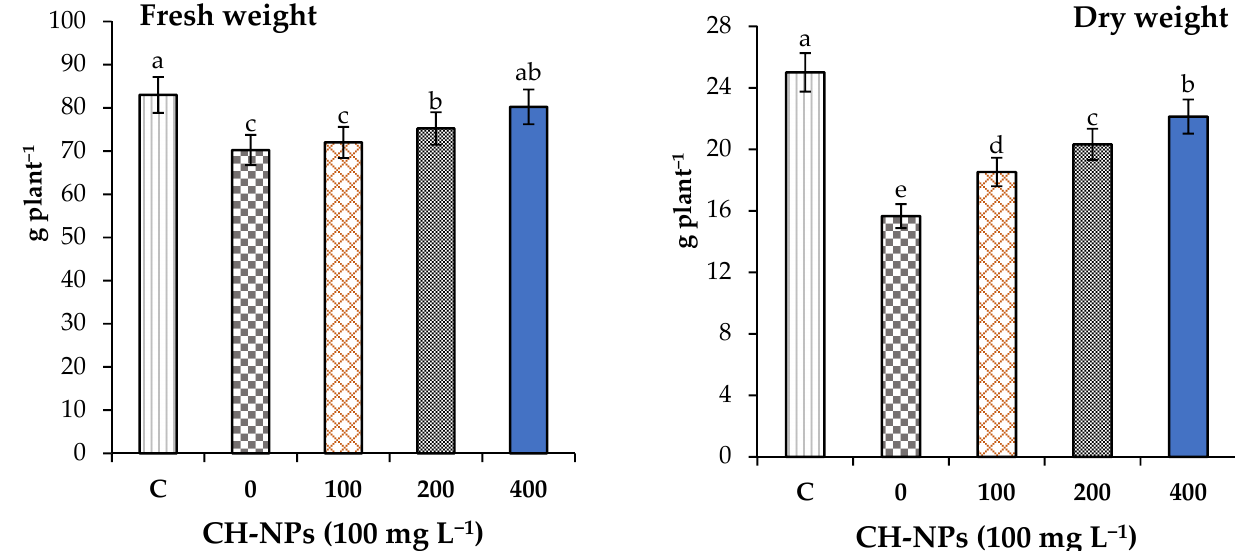
Figure 1. Effect of chitosan nanoparticles (CH-NPs) on the fresh and dry weights of banana plants exposed to cold stress (5 ◦ C for 72 h). C = control treatment without cold stress and without CH-NP amendment Different letters refer to significant differences between treatments according to Tukey’s test at p < 0.05. Each value is the mean of five replicates (mean ± SD, n =